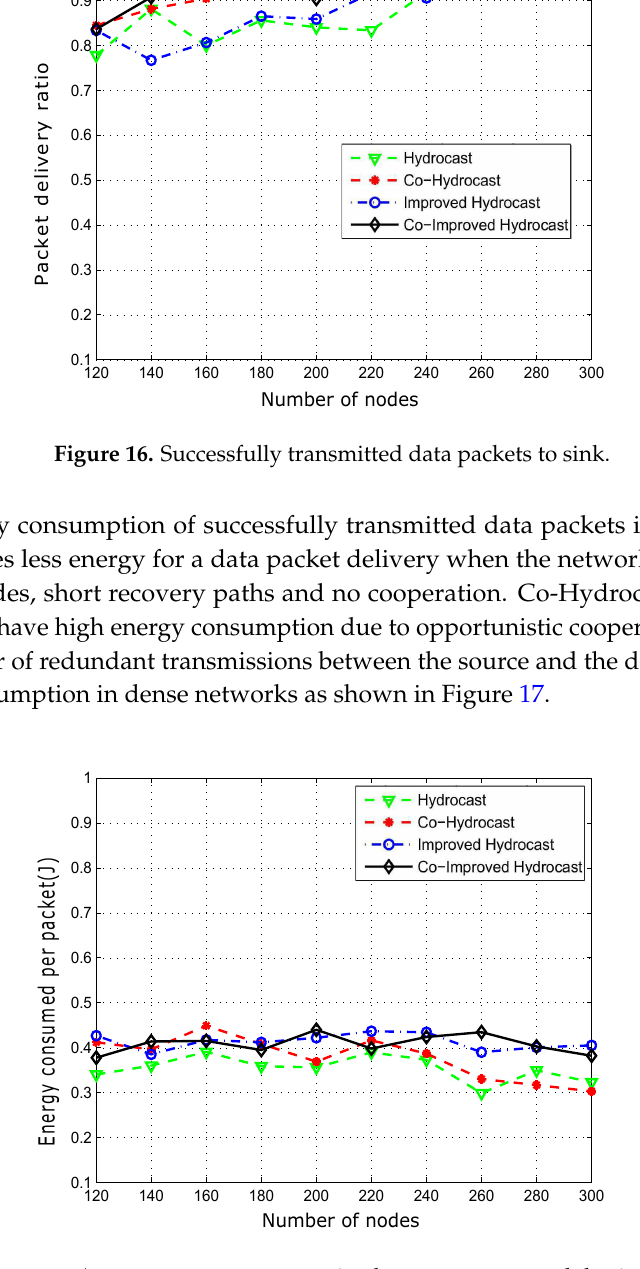
Figure 17. Average energy consumption between source and